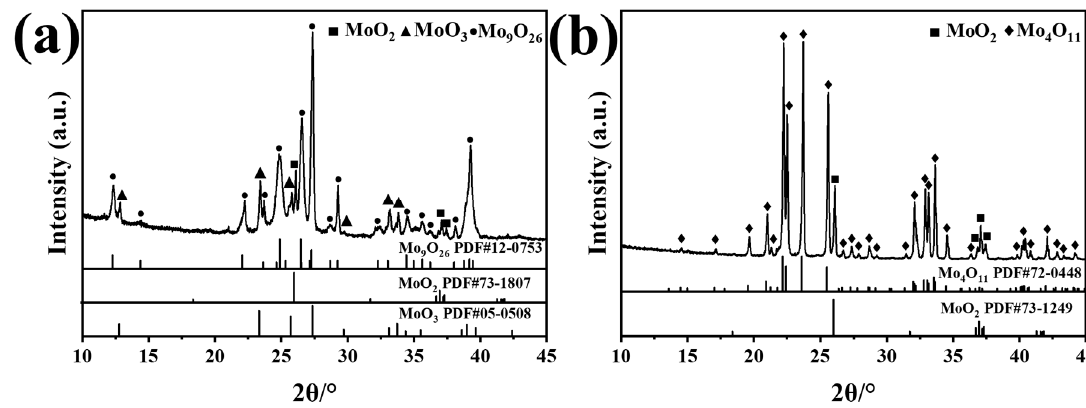
Figure 1. XRD pa tt erns of Mo 9 O 26 ( a ) and Mo 4 O 11 ( b ). Simultaneous TG–DSC curves for the Mo 9 O 26 and Mo 4 O 11 powders are shown in Figure 2. Figure 2a shows that the DSC curve contains three endothermic peaks at 774.1 °C, 811.3 °C and 1012.6 °C. There are three exothermic peaks at 805.1 °C, 885.6 °C